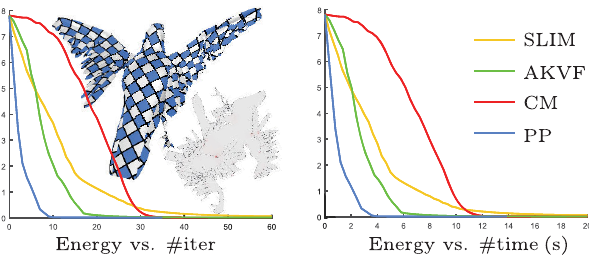
Fig. 7 Comparison for four competing methods, including CM [37], PP [35], AKVF [36], and SLIM [43]. Reproduced with permission from Ref. [35], c (cid:2) ACM